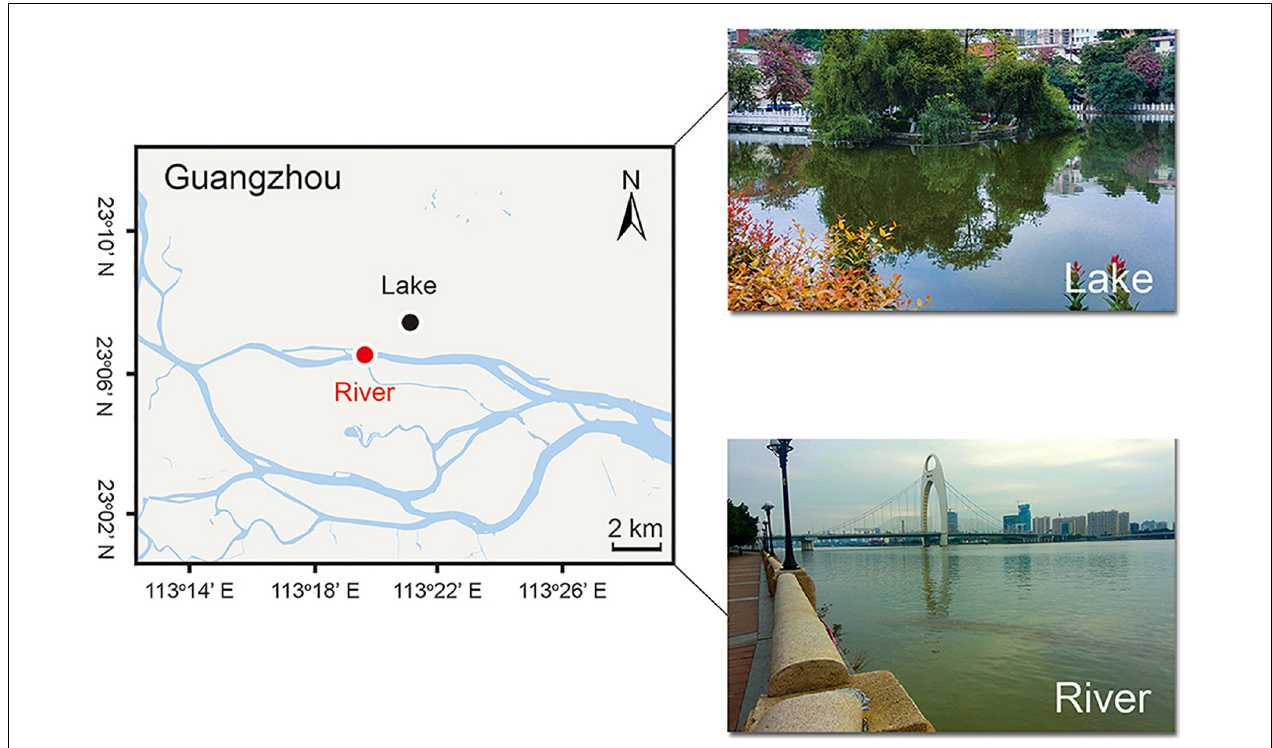
FIGURE 1 | Location of sampling